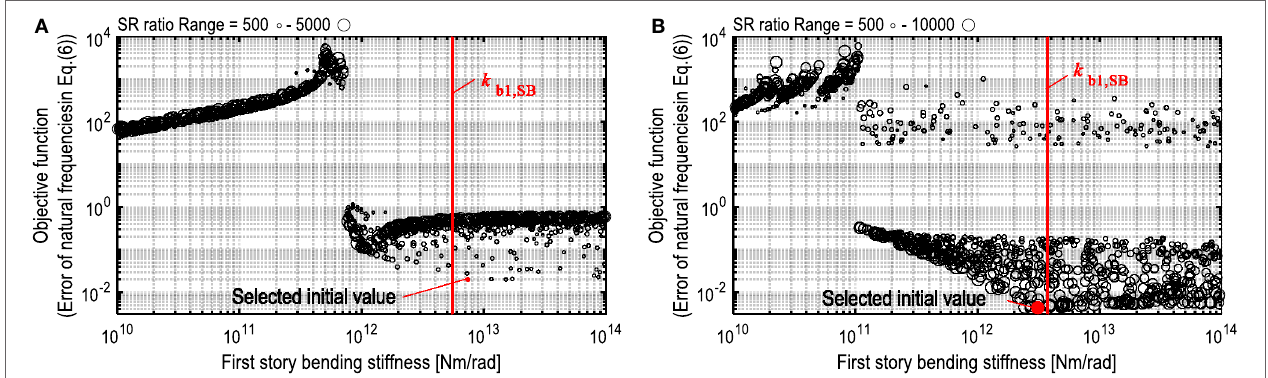
FIGURE 11 | Minimization of function in Eq. 6 for various initial values of first story bending stiffness and stiffness ratio by random search: (A) Model A and (B) Model B .